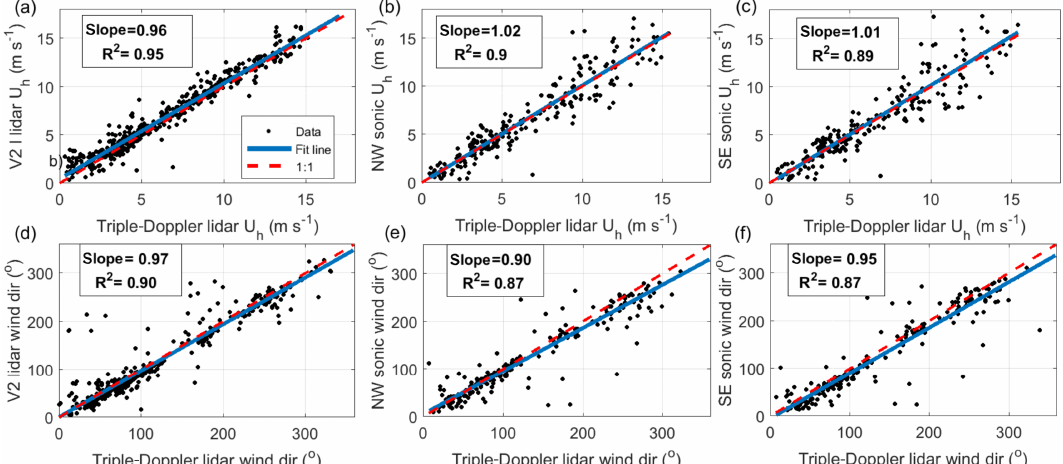
Figure 8. Linear regression of triple-Doppler lidar data against reference instruments for all the tested heights: (a–c) horizontal wind speed U h (ms − 1 ) ; (d–f) wind direction ( ◦ ).